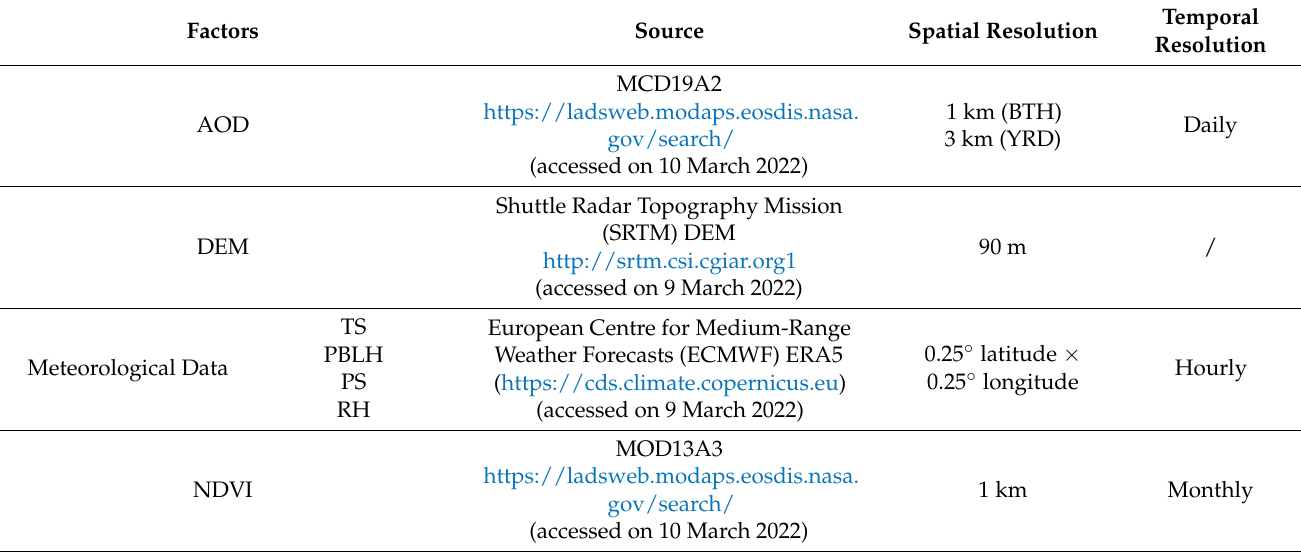
Table 1. The data sources of remote sensing and meteorological